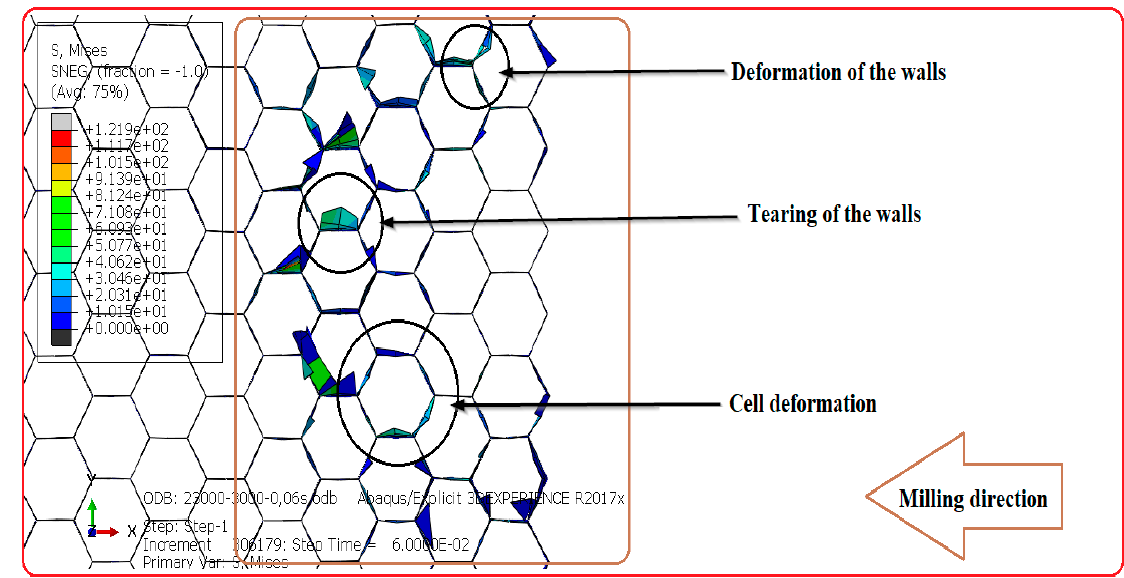
J. Manuf. Mater. Process. 2023 , 7 , x FOR PEER REVIEW Figure 17. Resulting machined surface quality by the cutting blade of 16.3 mm. Figure 17. Resulting machined surface quality by the cutting blade of 16.3 mm.